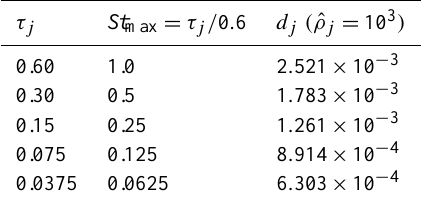
Table 1. Stokes time, maximum Stokes number and diameter of the solid particles inserted in the turbulent box.